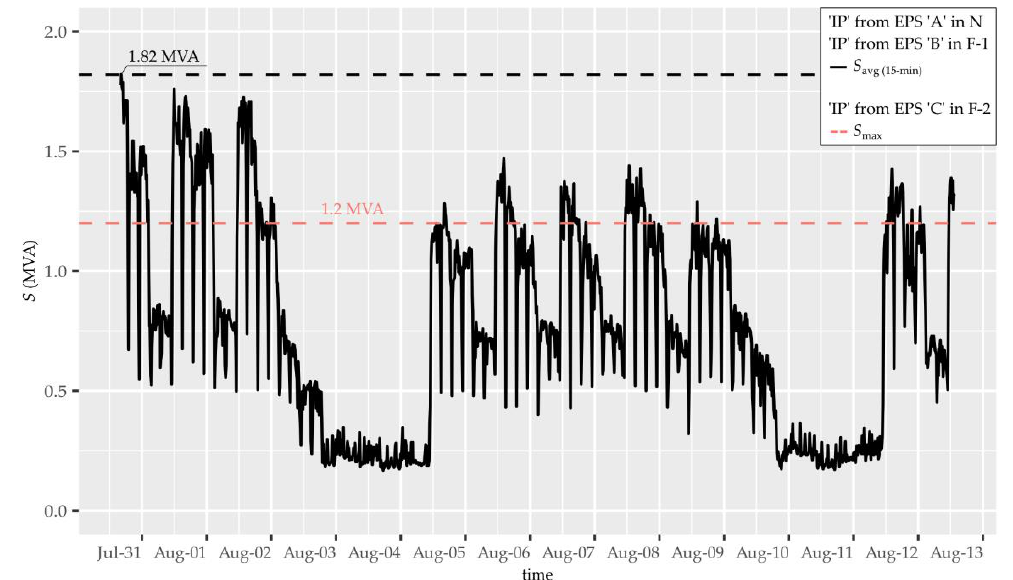
Figure 13. The S “IP” power profile of the industrial plant in the operating condition: N; F-1; F-2; F-2* . Due to the limited load capacity of the network from the EPS “C” substation side, resulting from the voltage condition, in the operating conditions F-2 and F-2* , the “IP” factory operates with a power limited to 1.2 MVA (in normal work—1.82 MVA). Figure 14 shows a 2-week power flow S of the substation EPS “A” in the island operation condition F-2* . In this condition, the substation supplies energy consumers in a selected, separated rural area (see Figure 4). However, the presented power flow applies to simulation tests, so it should be taken into account that, in this system, the power source will be BESS, and the backup time has been determined at a level not shorter than 1.5 h with a maximum load of 1.58 MVA (about 1.45 MW) in the summer.